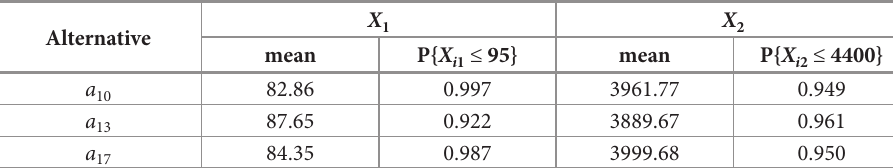
Table 7. Alternatives satisfying restrictions specified by the decision